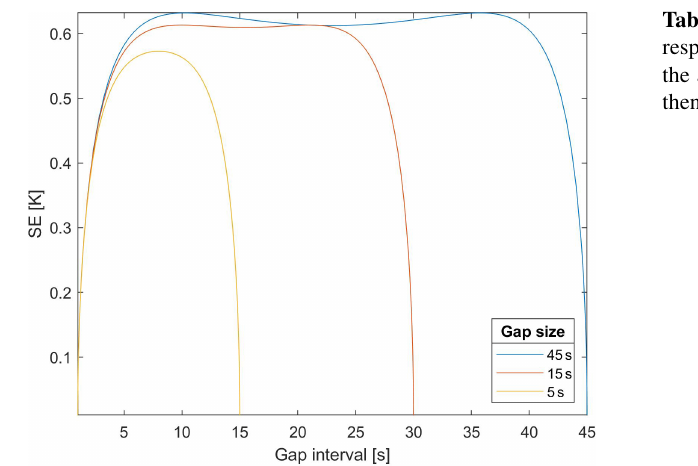
Figure 3. Linear interpolation SE, Eq. (8), as a function of the gap time for a GP with σ s = 0 . 5K, σ (cid:15) = 0 . 01K, and θ = 3s. Three gap sizes are considered: 45, 30, and 15s.